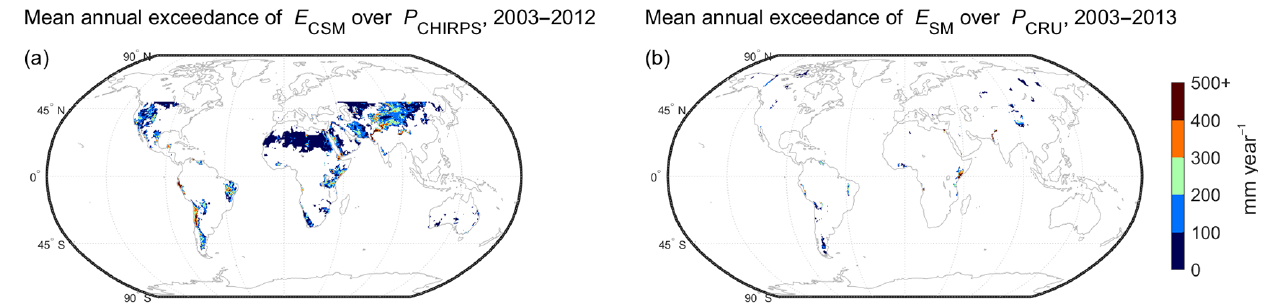
Figure A1. Mean annual accumulated exceedance of (a) E CSM (ensemble evaporation of CMRSET, SSEBop, and MOD16) over P CHIRPS , and (b) E SM (ensemble evaporation of SSEBop, and MOD16) over P CRU .